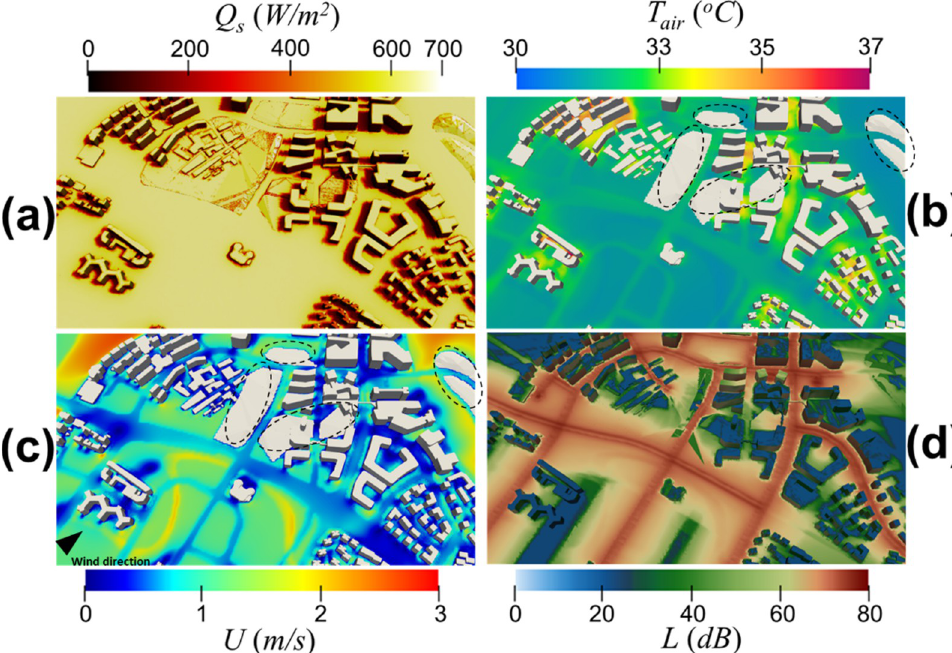
Fig 5. On the sunny day at 10:30, the figure shows (a) the solar irradiance mapping on the surface of the district, (b) air temperature as well as (c) wind speed contours at pedestrian level cut-plane (i.e., 1.5m) of the district, and (d) the noise level mapping on the surface of the district. The regions circled in (b) and (c) indicate that the terrain is higher than the 1.5m pedestrian level cut-plane. The arrow in (c) denotes the wind